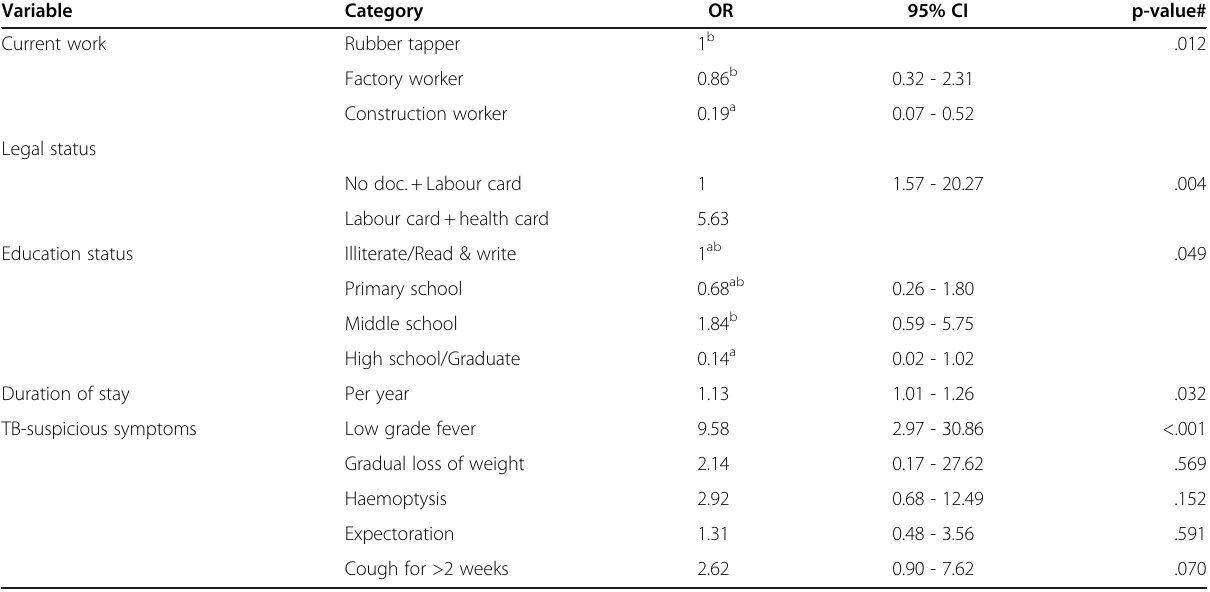
Table 7 Mixed effects logistic regression model of healthcare-seeking at any modern healthcare facility for TB- suspicious symptoms